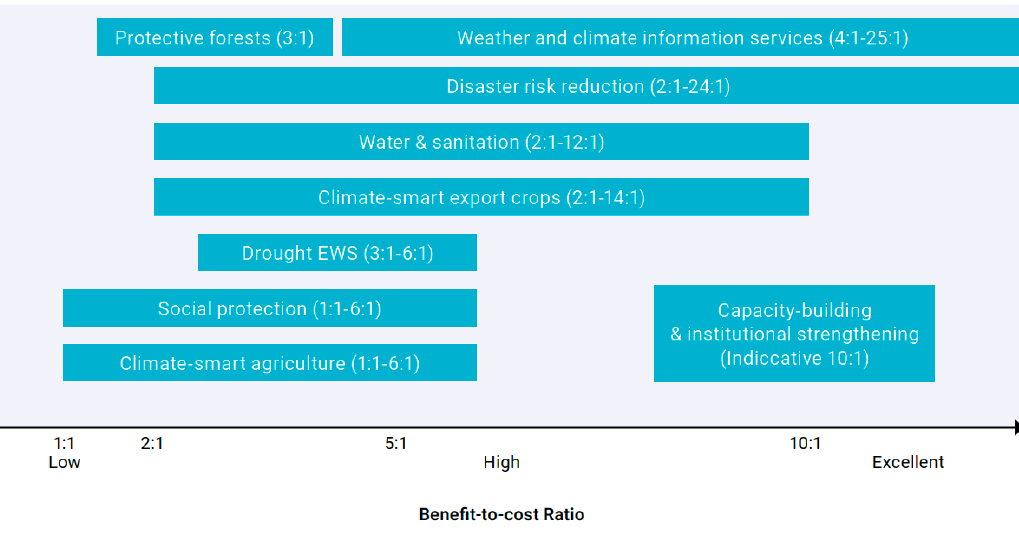
Figure 1. The representative benefit-to-cost ratio ranges for different adaptation measures based on information review from Africa. Photo credit: The Global Center on Adaptation [53] .